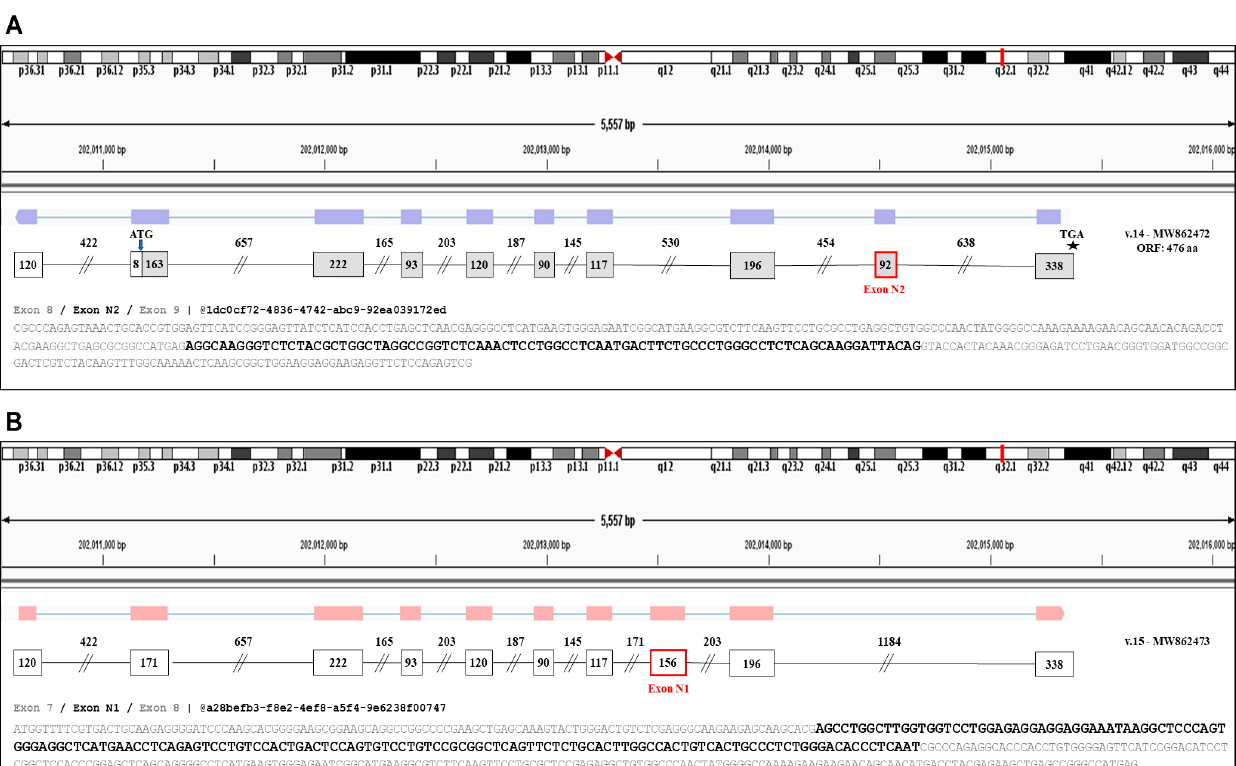
Figure 2. Schematic demonstration of the two identified exons (N1 and N2) as well as indicative sequencing reads verifying them. ( A ) Alignment of the new transcript ELF3 v.14 that contains Exon N2. Based on the nanopore sequencing data, exon N2 is located between the annotated exons 8 and 9. ( B ) Alignment of the new transcript ELF3 v.15 that contains Exon N1. Based on the nanopore sequencing data, exon N1 is located between the annotated exons 7 and 8.